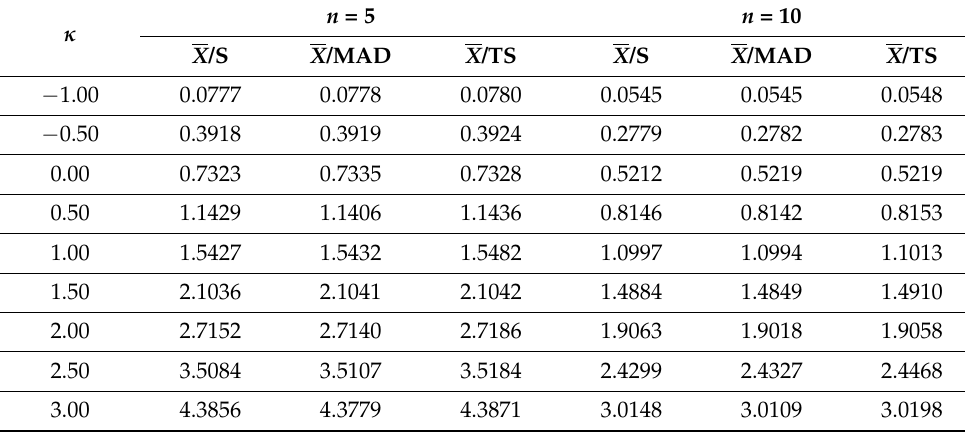
Table 6. Average length of the control limits for the WV control